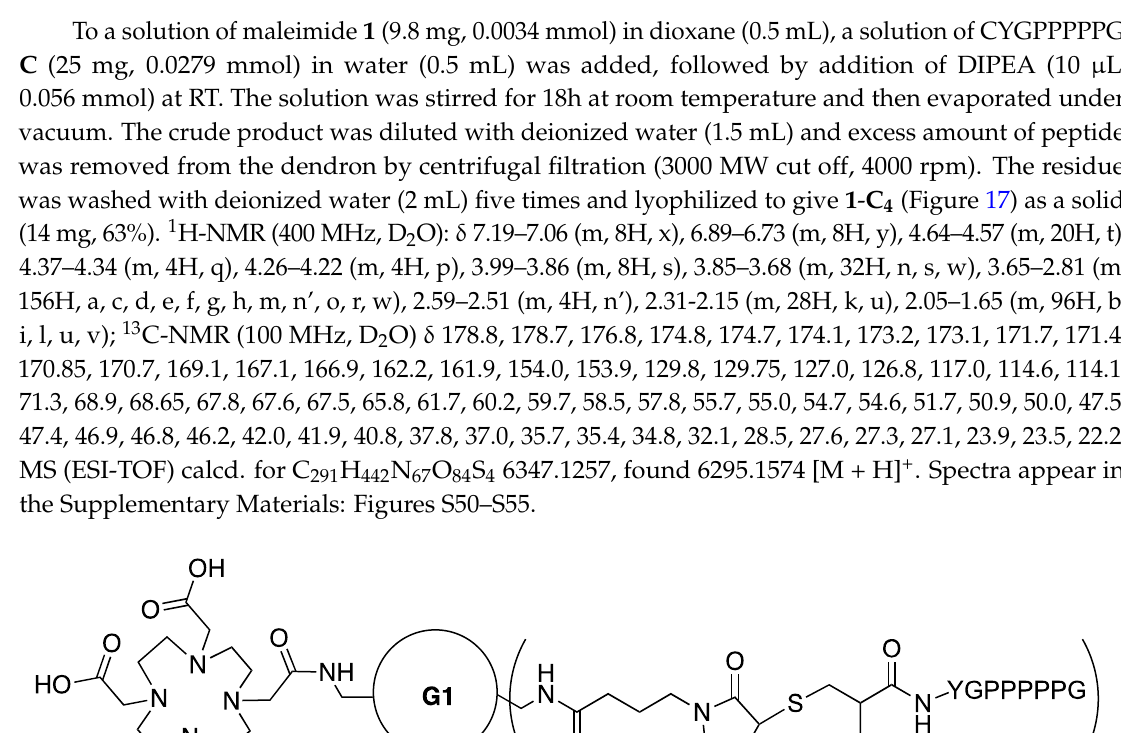
Figure 14. Dendrimer 1 - B 4 . Figure 16. Dendrimer 1 - B